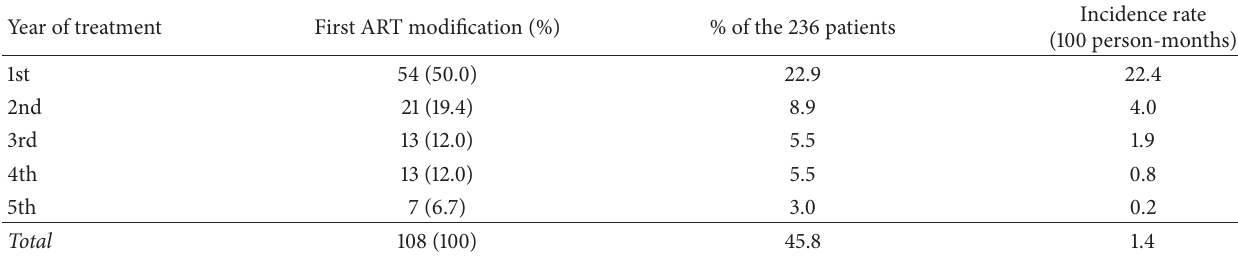
Table 2: Frequencies of first ART modification and incidence rate by years after the beginning of treatment.